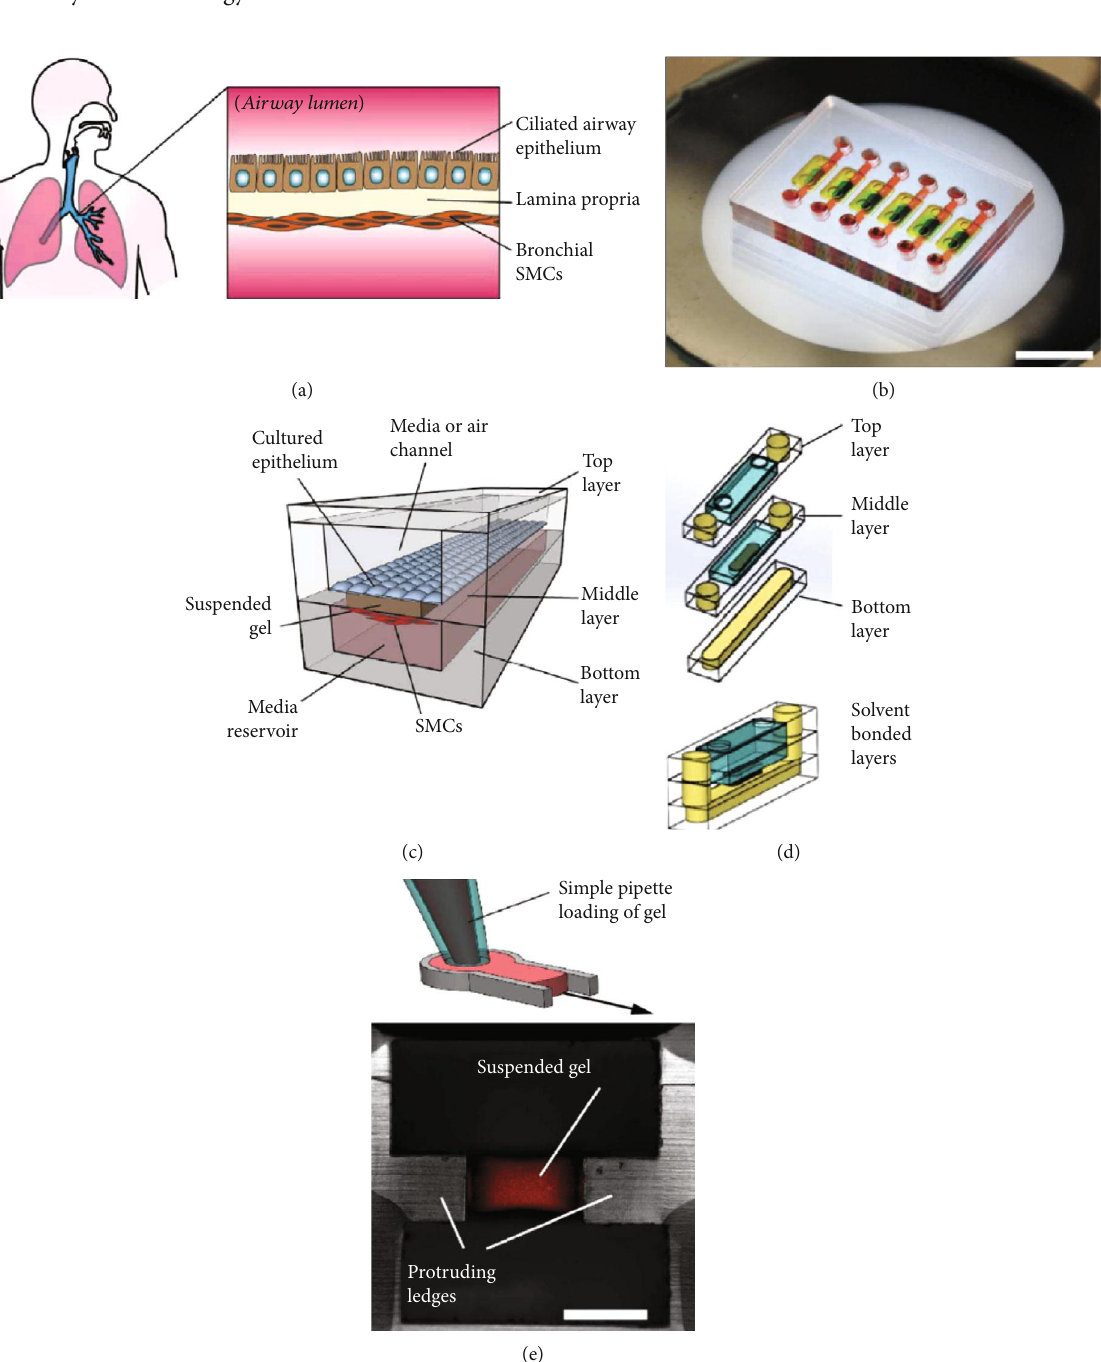
Figure 8: Lung airway-on-a-chip device design and fabrication. (a) Schematic of airway lumen tissue structure. (b) Photograph of an assembled lung airway microdevice ( scalebar = 10mm ). (c) Lung airway microdevice schematic design. (d) Exploded view of the three PMMA layers. (e) The suspended hydrogel is introduced into the middle layer. Magni fi ed image of the device cross-section ( scale bar = 500 μ m ). Reproduced (or adapted) with permission [68], ©2018, Royal Society of